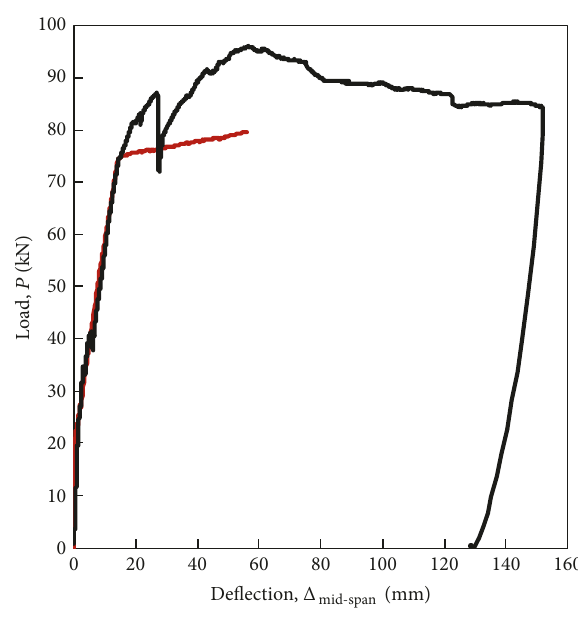
Figure 10: FE model